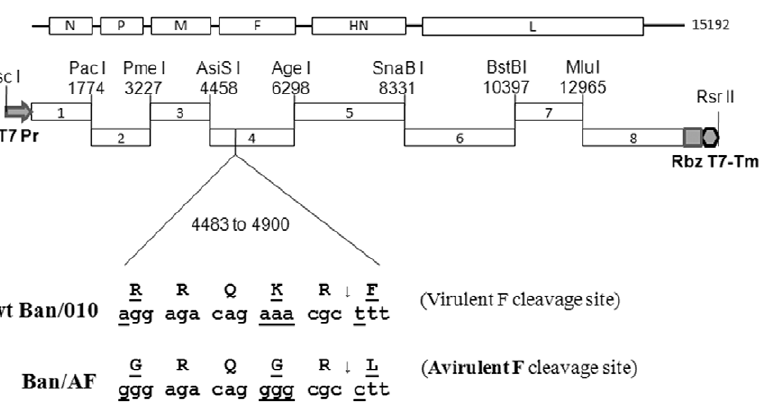
Figure 2. Construction of a full-length antigenomic cDNA of NDV Indonesia strain Ban/010 and modification of its F protein cleavage site. (A) Construction of the antigenomic cDNA. Eight cDNA fragments were generated from viral RNA by RT-PCR using primers that inserted seven unique restriction sites (sequence positions are indicated). Using these sites, the cDNA fragments were inserted sequentially into the pBR322/dr plasmid vector, flanked on the upstream side by a T7 RNA polymerase promoter sequence and on the downstream side by the hepatitis delta virus ribozyme sequence (Rbz) followed by a T7 terminator sequence (Tm). (B) Modification of the F protein cleavage site. The sequence of the cleavage site of the wt Ban/010 virus is shown, as well as the altered cleavage site in mutant Ban/AF. The mutated residues and nucleotides are shown in bold. The arrow indicates where cleavage occurs. doi:10.1371/journal.pone.0052751.g002 PLOS ONE |